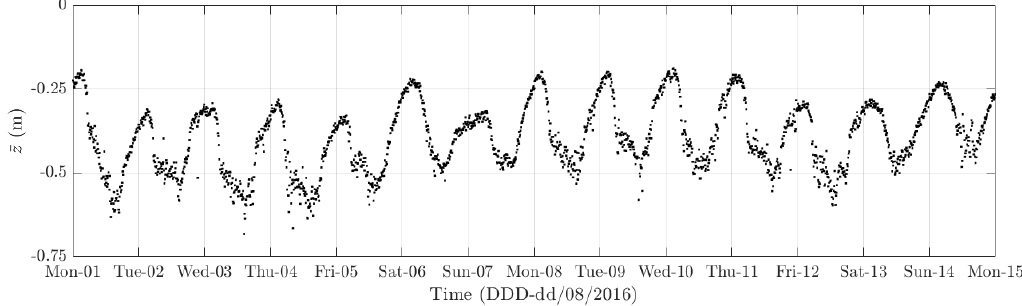
Figure 21. Variation of the 10 ‐ min mean of the heaving deformation from 1 to 14 August 2016.